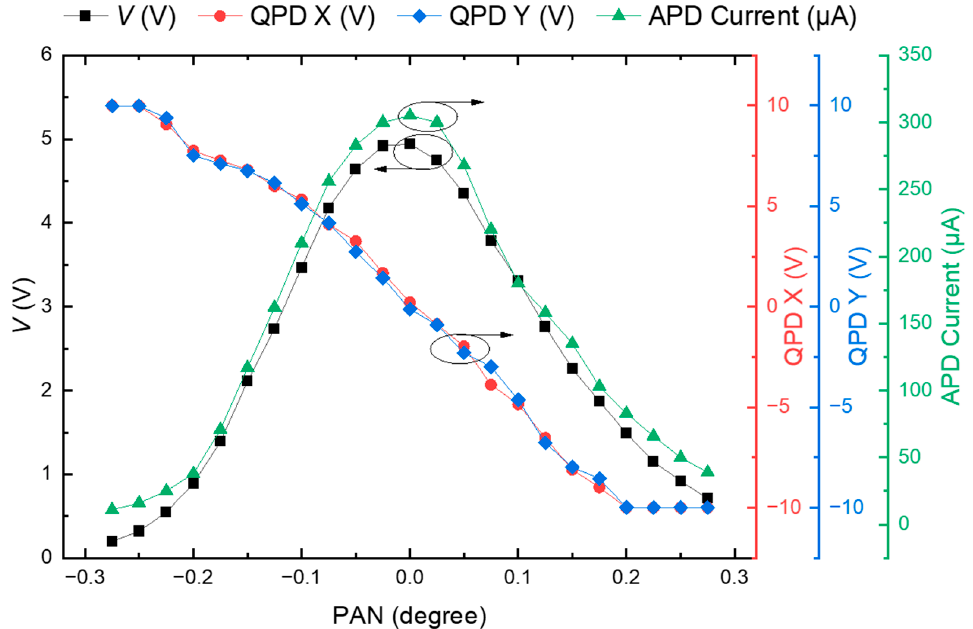
Figure 4. Result of I value of QPD, X value of QPD, Y value of QPD, and current value of APD with pan angle variation of PTU (incident beam size on the QPD = QPD size).